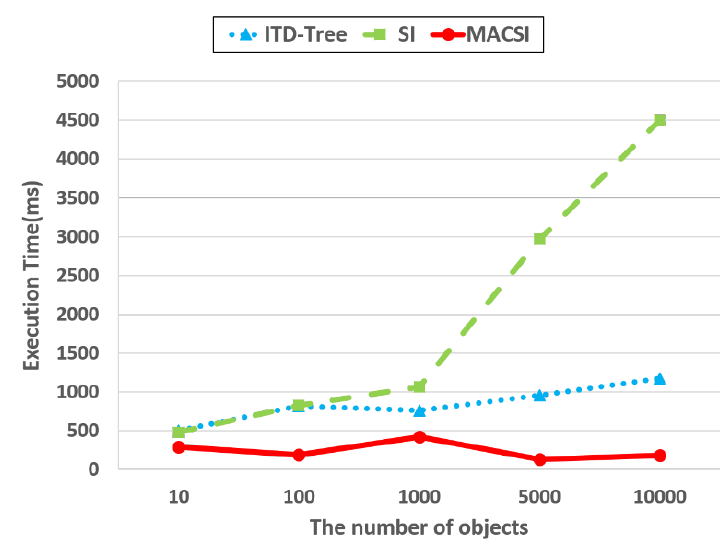
Figure 23. The effect of object number on the fine-grained semantic object query performance .